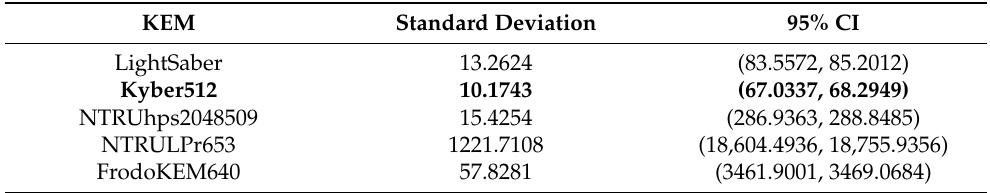
Table 6. The standard deviation and 95% CI values of CPU usage for the operation encryption , for each of the KEMs.